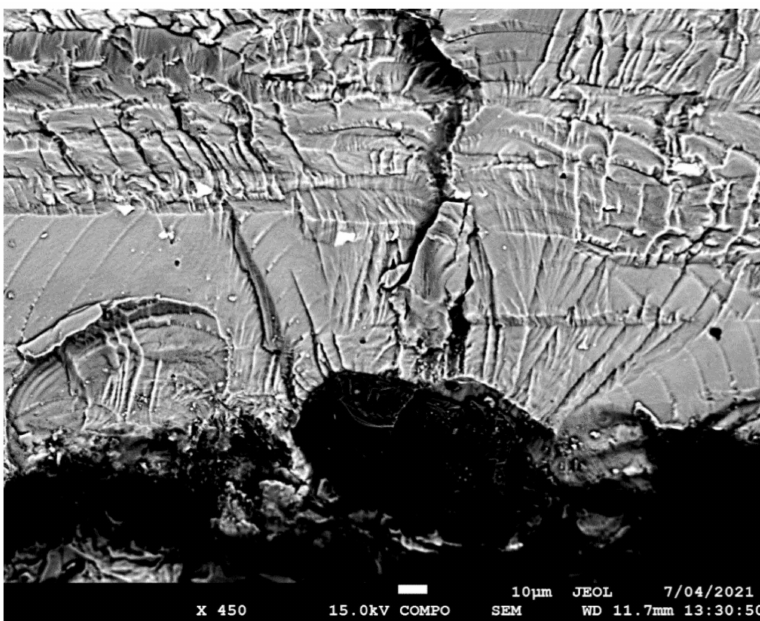
Figure 5. SEM of the lead crack (Crack 1) in specimen 1.